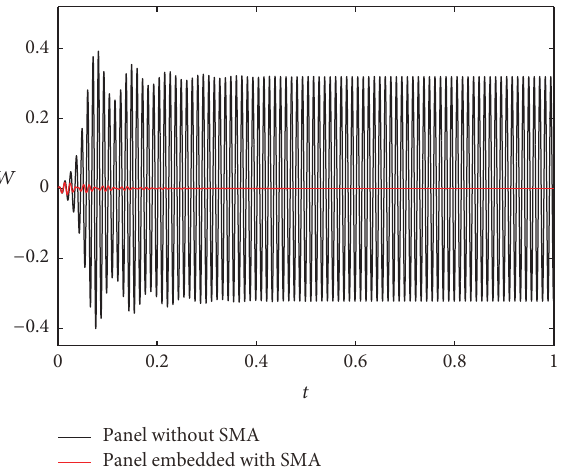
Figure 13: Time history for 𝜆 = 90 and Δ𝑇 = 0.5Δ𝑇 cr .